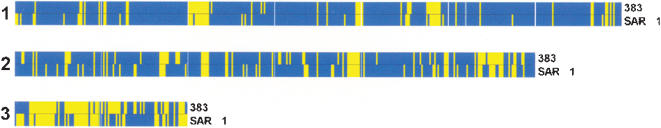
Genomic distribution of Burkholderia SAR-1 and B. cepacia 383 genes homologous to B. cenocepacia J2315. The distribution of homologous genes (blue) and absent genes (yellow) are shown for each B. cepacia complex Group K genome (indicated on the right). The panels correspond to the three J2315 chromosomes (chromosome number indicated on the left).